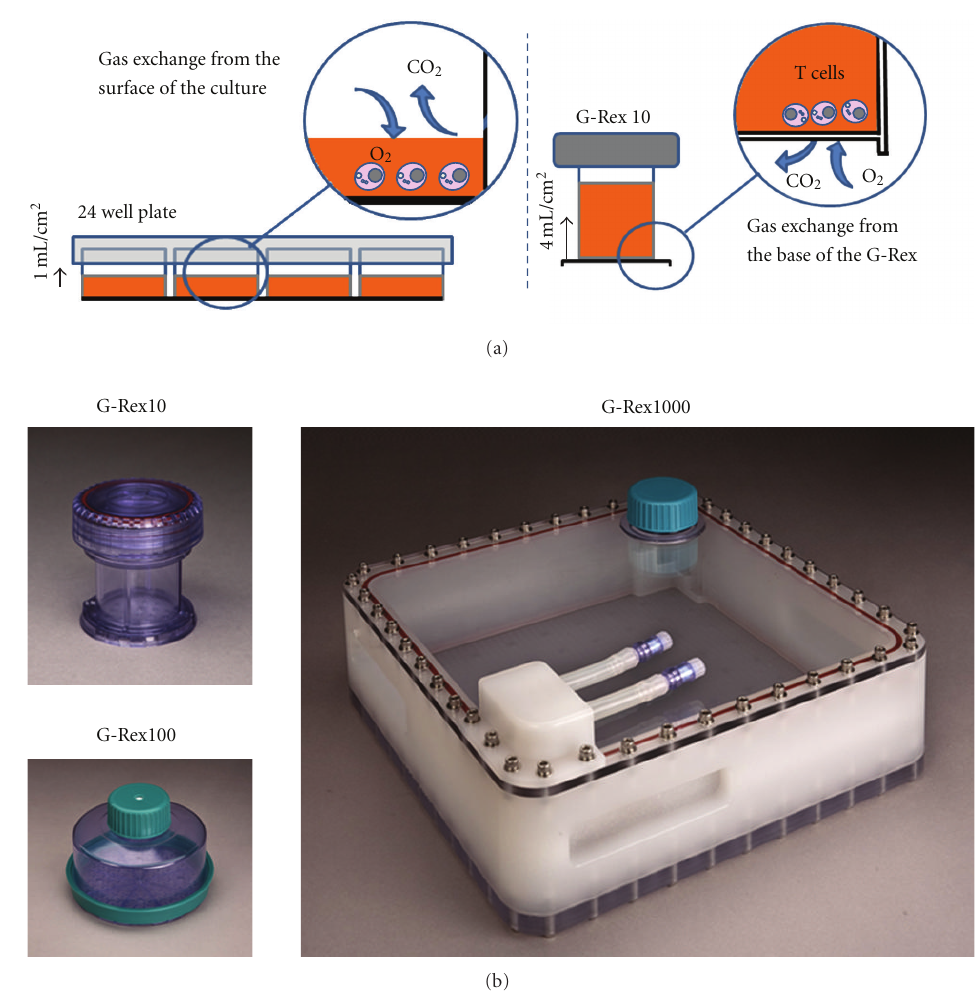
Figure 4: G-Rex culture device. (a) shows the limited gas exchange that occurs in conventional cultureware, which limits the volume of media and consequently the available nutrients. In contrast the G-Rex provides gas exchange from the base of the flask which allows cells to be cultured with a superior ratio of media per surface area. (b) shows the G-Rex10 with a surface area of 10 cm 2 and a volume capacity of 40mLs, the G-Rex100 with a surface area of 100 cm 2 and a volume capacity of 500 mLs, and the G-Rex1000 with a surface area of 1000 cm 2 and a volume capacity of 5000